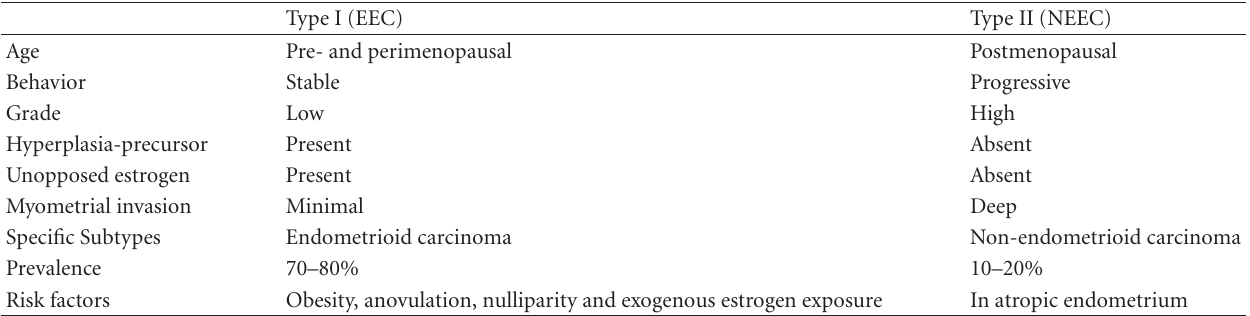
Table 1: Clinical and pathological features of endometrial carcinoma.